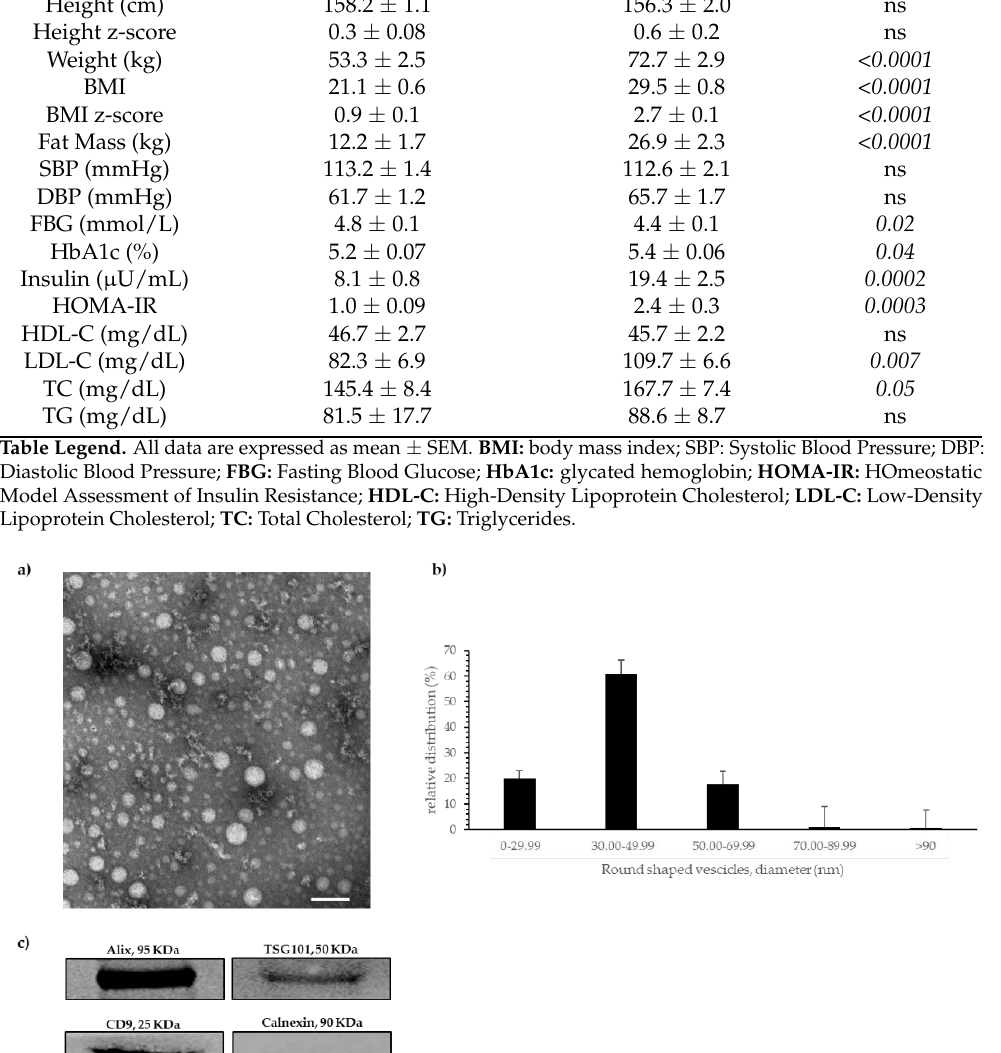
Table Legend. All data are expressed as mean ± SEM. BMI: body mass index; SBP: Systolic Blood Table 1. Demography, clinical characteristics, body composition and biochemical variables of the Pressure; DBP: Diastolic Blood Pressure; FBG: Fasting Blood Glucose; HbA1c: glycated hemoglobin; study population. HOMA-IR: HOmeostatic Model Assessment of Insulin Resistance; HDL-C: High-Density Lipo- protein Cholesterol; LDL-C: Low-Density Lipoprotein Cholesterol; TC: Total Cholesterol; TG: Tri- glycerides.